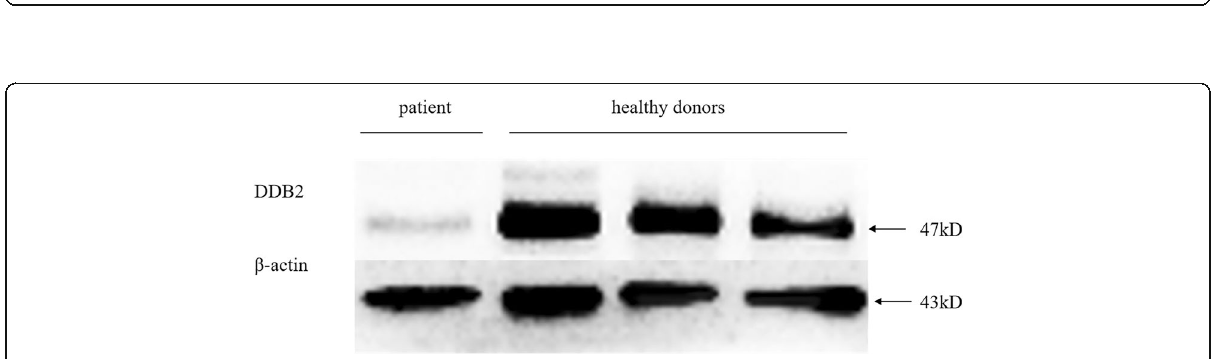
Fig. 2 Novel deletion mutation in the DDB2 gene was detected in the patient. a . Homozygous mutation. b . Heterozygous state. c . Confirmation of the mutation at the cDNA level